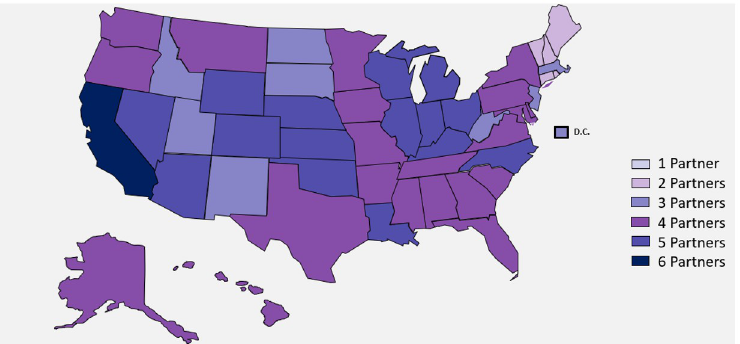
Fig 1. Geographic coverage of data datasets. Reprinted from brightcarbon.com under a CC BY license, with permission from Bright Carbon, original copyright (2021). Each color represents the number of data partners with a presence in each state but does not necessarily correspond to the number of people. The darkest color represents those where all six partners had a